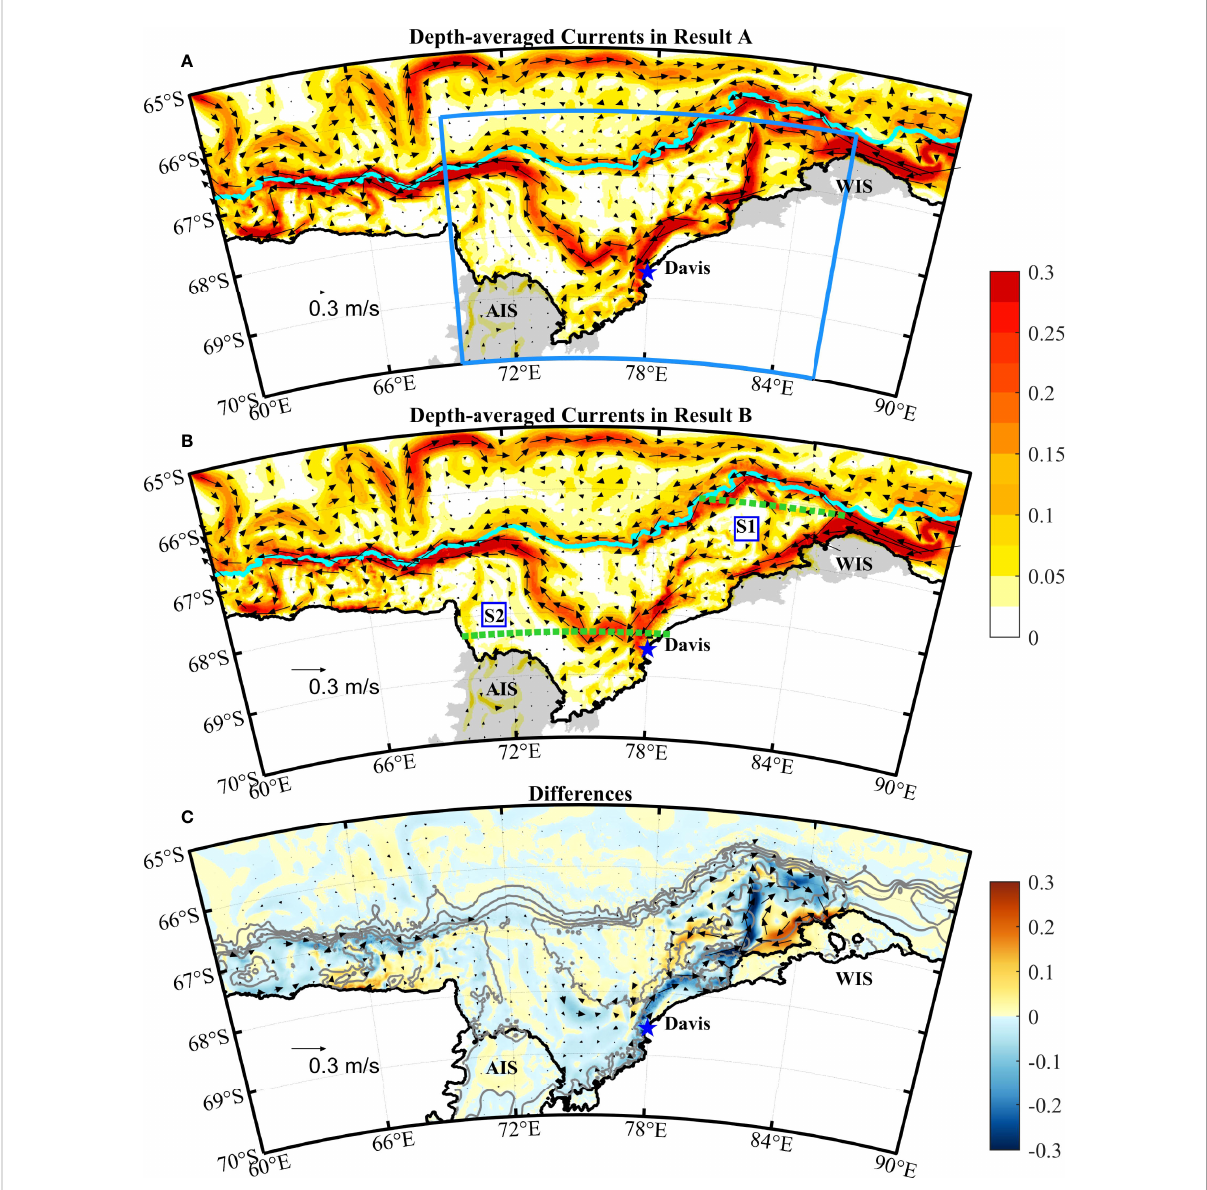
FIGURE 3 (A) The speeds (m s -1 ) (color shading) and vectors of the depth-averaged currents in Result A. (B) Same as (A) , but for Result B. (C) The differences between Result A and Result B (B minus A). The heat transport within the region bounded by the light blue box (including only the continental shelf and parts of the sub-ice-shelf cavities) in (A) is shown in Figure 6. In (B) , the cross-sections (green dashed line) where the heat transports are shown in Figure 7 are labelled by S1 (66.1°S) and S2 (68.3°S), respectively. The semitransparent regions denote the AIS and the WIS. The solid black lines are the coastlines and the ice-shelf fronts. The grey lines are bathymetric contours in CB, with 500 m intervals from 500 m to 2000 m depth. The cyan line are 1000 m bathymetric contours in